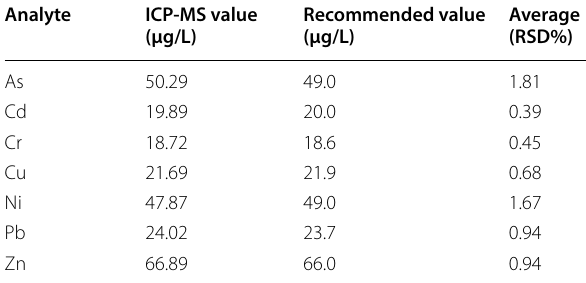
Table 3 Heavy metal data for water reference sample NIST 1643b by ICP-MS (Krishna and Mohan 2014)